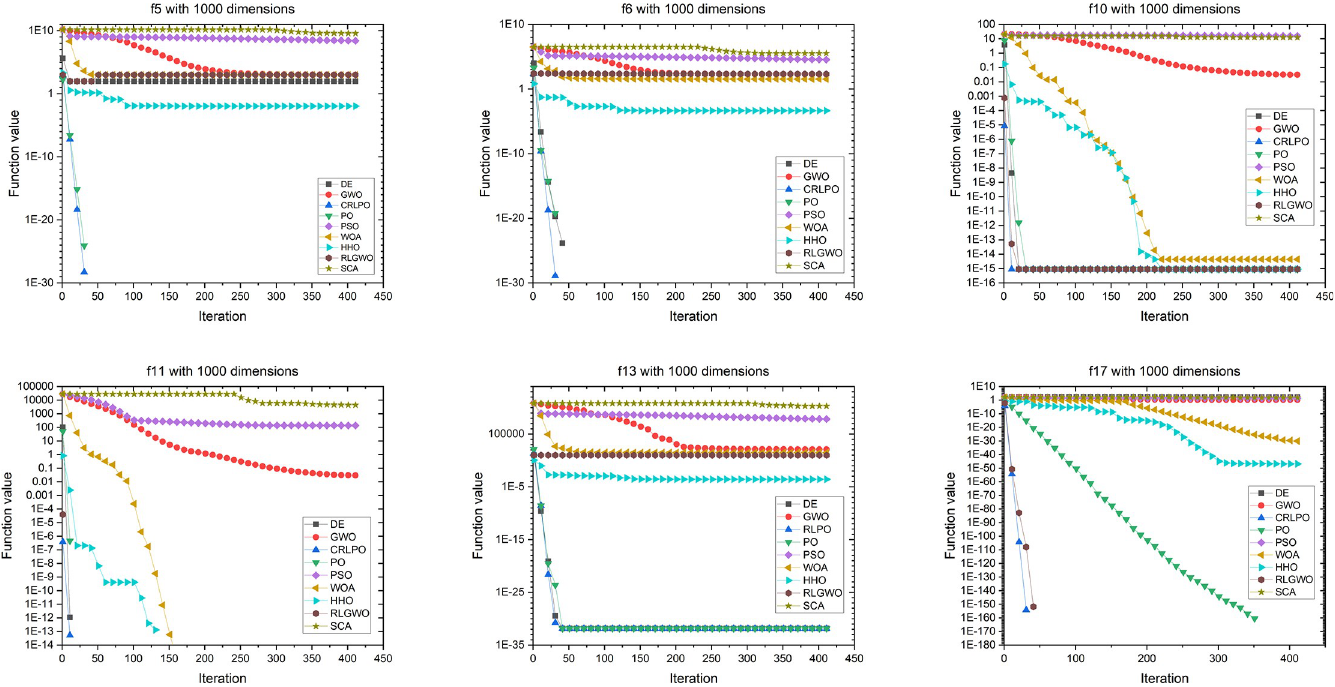
Fig 16. Convergence graph of CRLPO as well as eight other algorithms on six representative benchmark functions with 1000 dimensions.